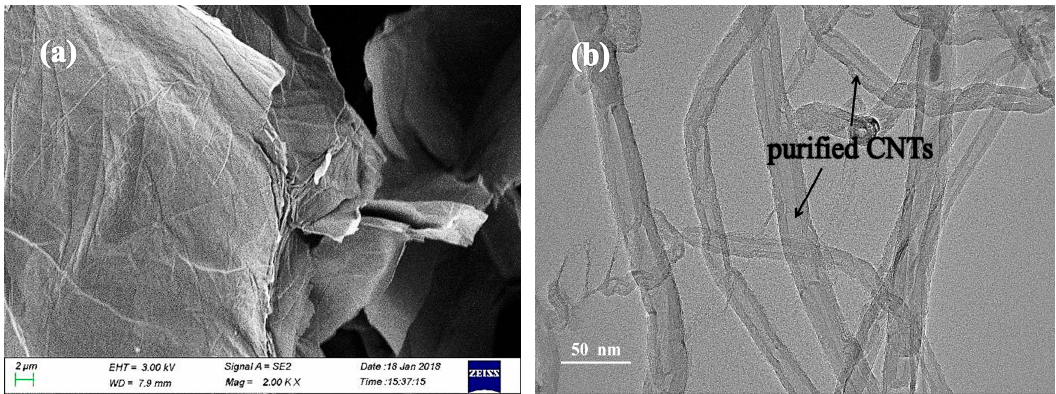
Figure 1. SEM image ( a ) of graphene oxide (GO) powder and TEM image ( b ) of purified carbon nanotubes (CNTs).